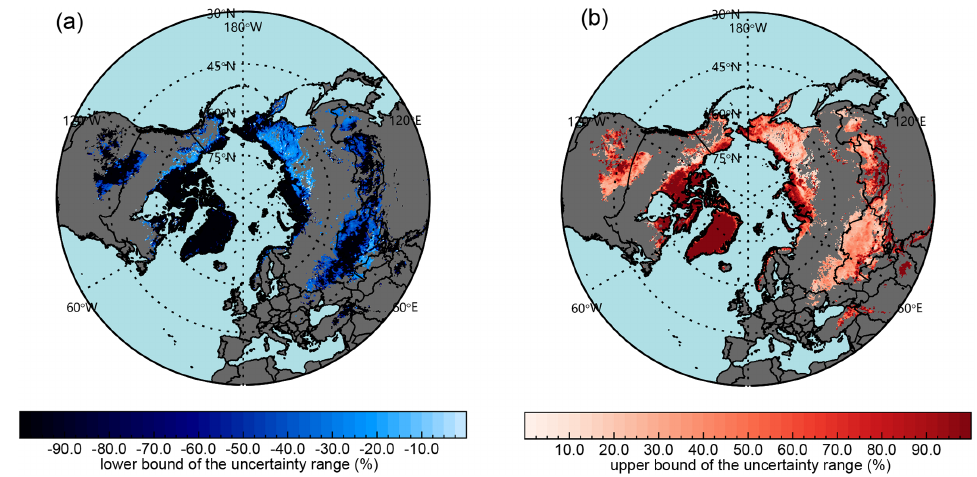
Figure 8. The overall lower bound and upper bound of the uncertainty range of radiative forcing retrieval due to atmospheric correction, MODIS-derived snow grain size retrieval, and snow cover fraction calculation.